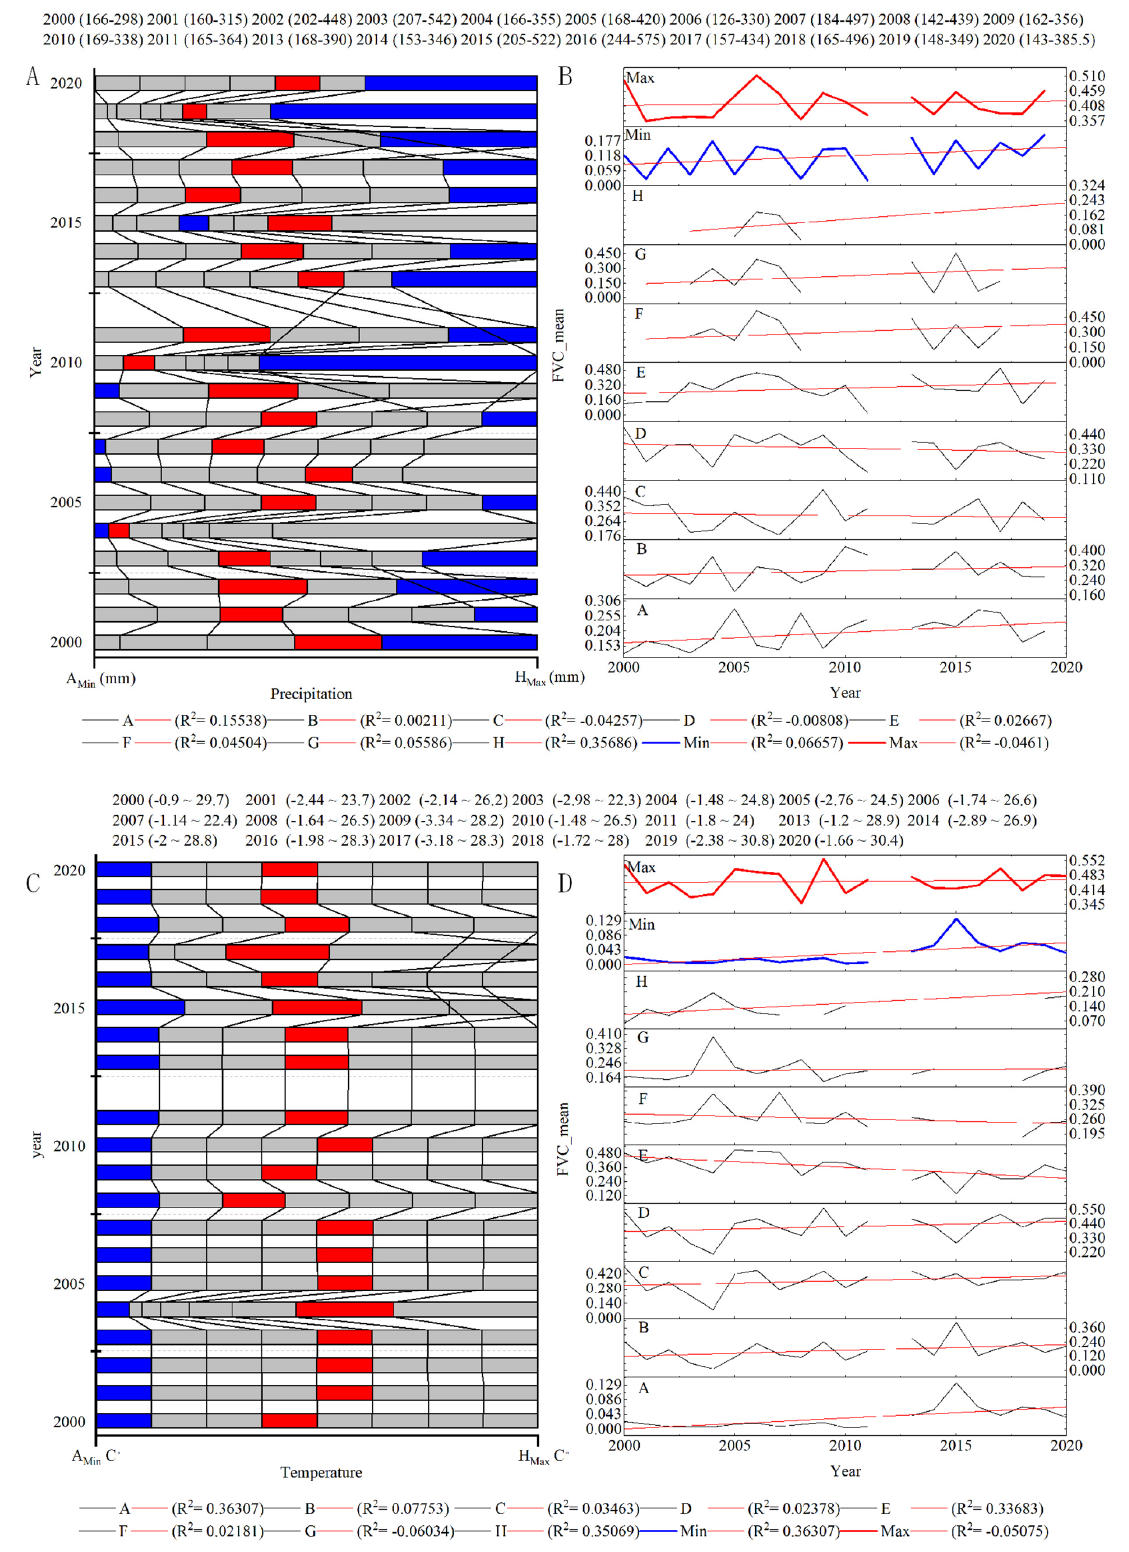
Figure 12. Analysis of the climate characteristic risk area based on the OPGD model: ( A ) precipi- tation risk areas; ( B ) FVC mean values for each precipitation risk areas; ( C ) temperature risk areas; ( D ) FVC mean values for each temperature risk areas; (red line) maximum FVC mean value in risk area; (blue line) minimum FVC mean value in risk